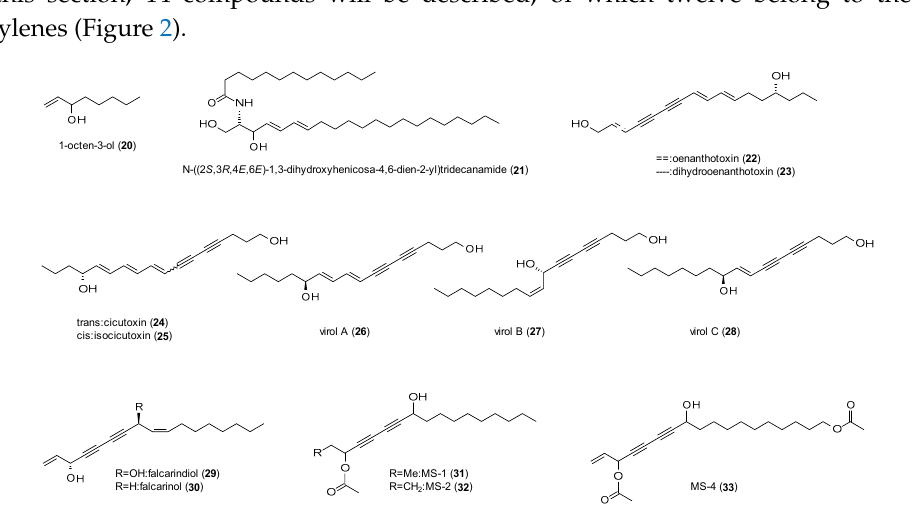
Figure 2. Chemical structures of alkanes with reported GABA(A)-receptor modulating activity.